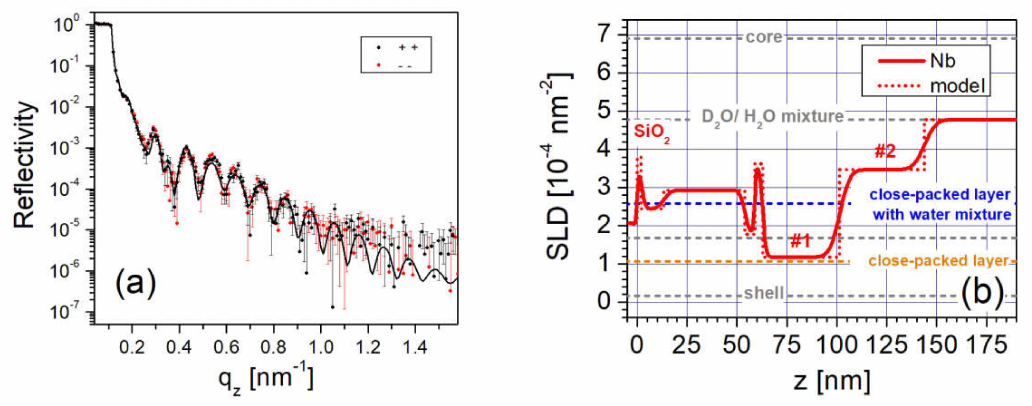
Figure 10. ( a ) PNR data and fit (solid line) for a FF with iron oxide NPs with a diameter of 22.2 nm in contact with a 40 nm Tb 15 Co 85 film in a small in-plane guide field (approximately 1 mT). ( b ) Nuclear SLD profile as a function of distance z from the Si surface obtained from model fits to the PNR data. The Tb 15 Co 85 surface is near z = 50 nm. The first and second NP layers (#1 and #2) are